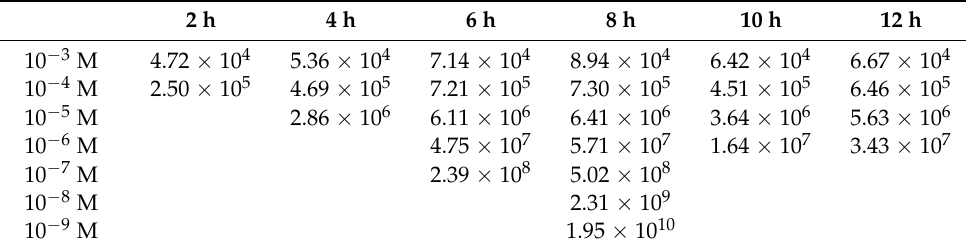
Table A1. The enhancement factor calculated for the substrate with different silver nanoparticle deposition times.